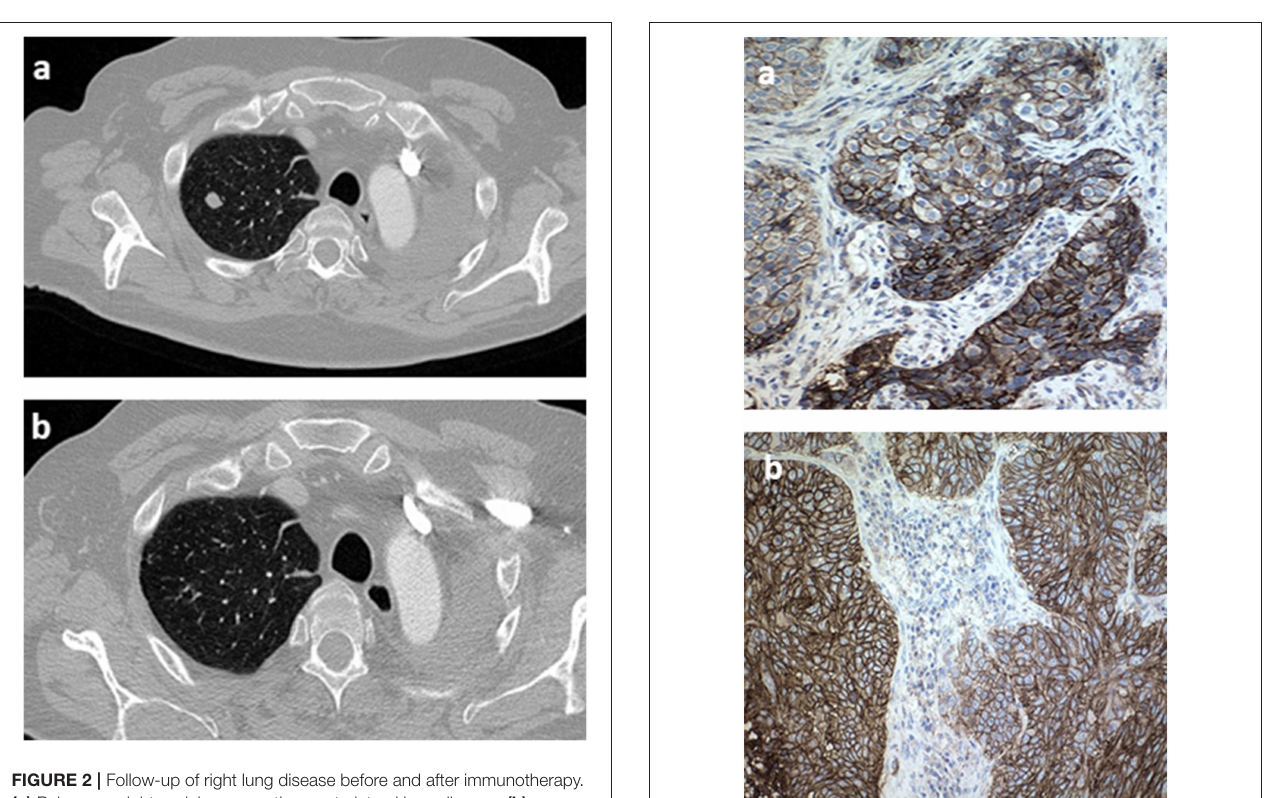
FIGURE 2 | Follow-up of right lung disease before and after immunotherapy. (a) Pulmonary right nodule, suggesting contralateral lung disease. (b) Complete lung response during nivolumab treatment.